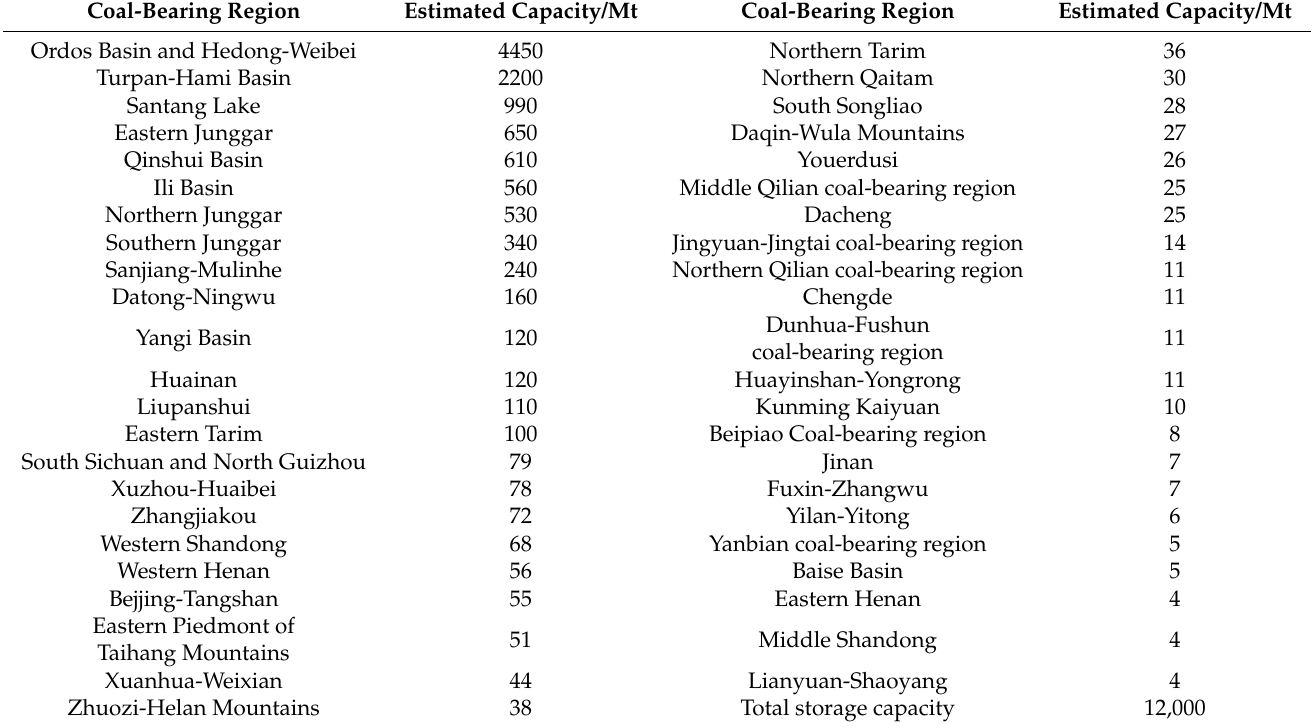
Table 1. Geological storage of CO 2 in 45 major coal-bearing basins in China